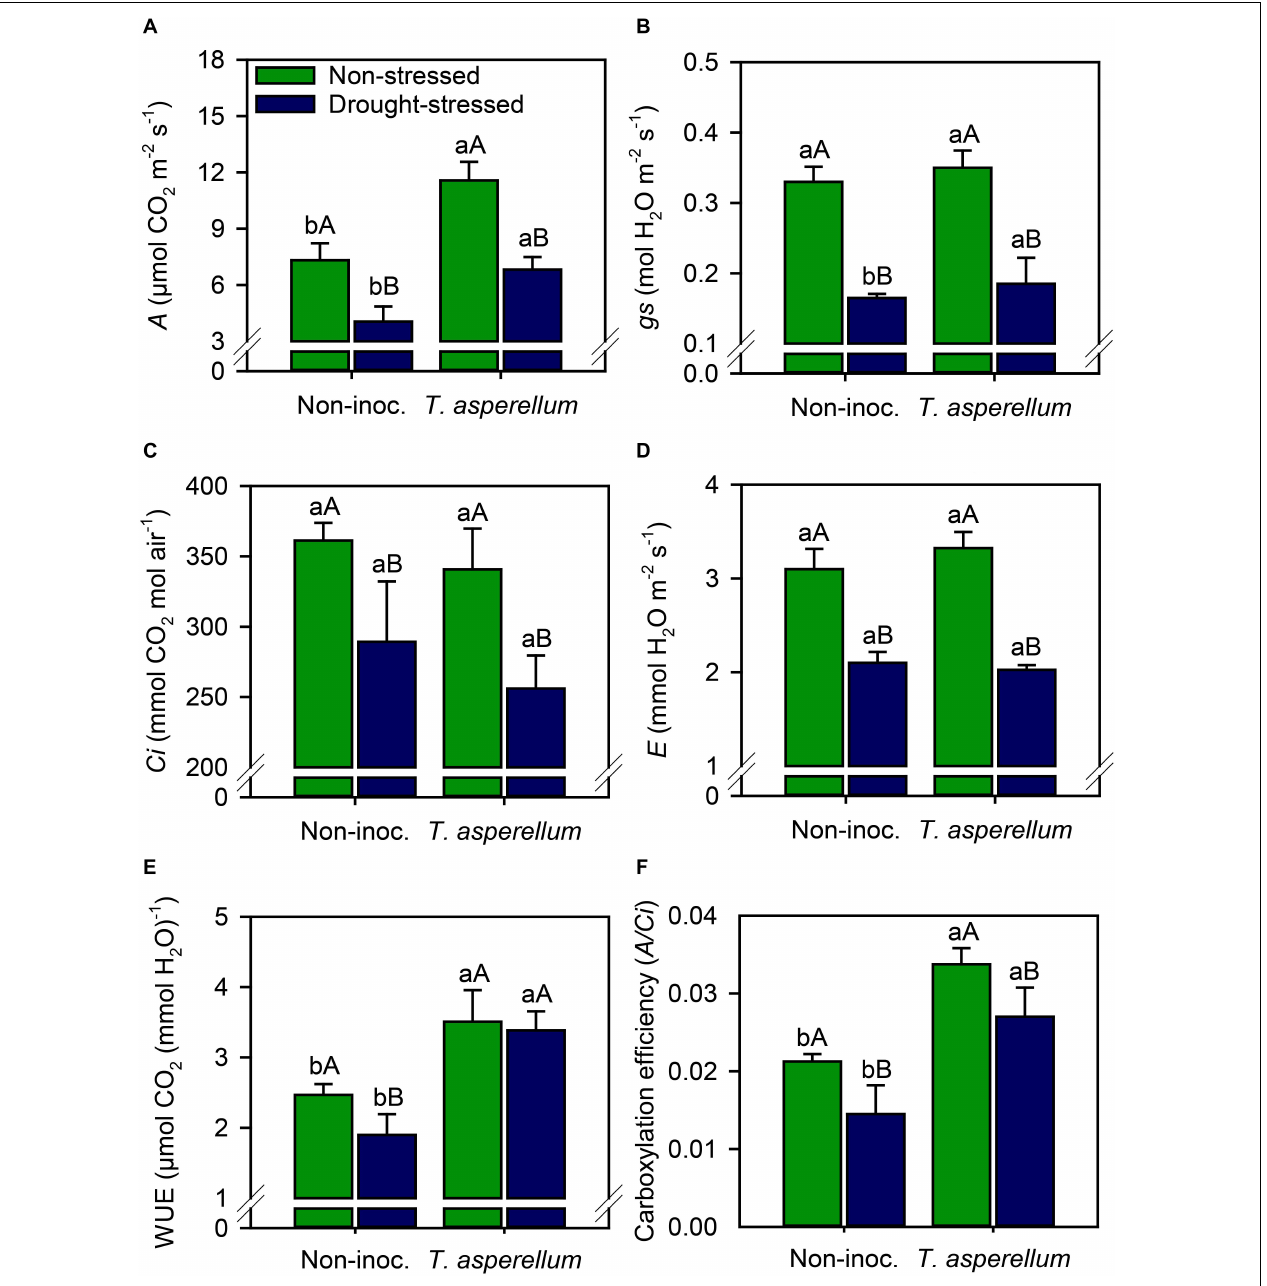
FIGURE 3 | Net photosynthesis rate (A) , stomatal conductance (B) , substomatal CO 2 concentration (C) , leaf transpiration (D) , water use efficiency (E) , and carboxylation efficiency (F) measured in sugarcane leaves according to the treatments. Different lowercase letters indicate significant differences between presence and absence of moderate drought stress, and different capital letters indicate significant differences between presence and absence of inoculation with T. asperellum by Fisher’s protected LSD test at p ≤ 0.05. Error bars express the standard error of the mean ( n = 4).